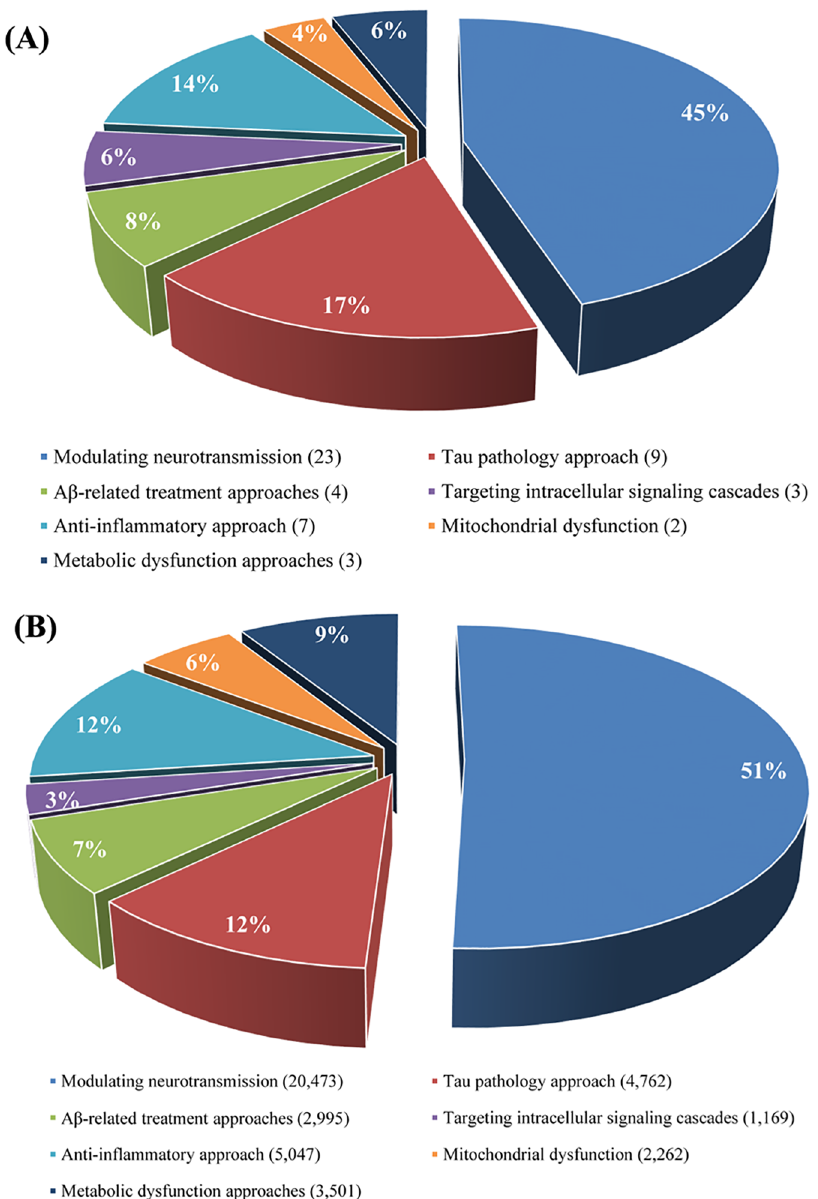
Fig 3. Targets (A) and active compounds(B) classification within the entire data set in AlzhCPI. minimum, lower quartile (Q1), median quartile (Q2), upper quartile (Q3), and maximum of MCC values of test sets. As shown in Fig 4A, among the four types of classifiers, the NB_ ECFP6 models (Q2 = 0.953) outperform the other three, and the NB_MACCS classifiers (Q2 = 0.651) perform the worst. However, there are no obvious differences between the perfor- mance of RP_ECFP6 (Q2 = 0.816) and RP_MACCS (Q2 = 0.757). As they are based on the same fingerprint, it is interesting that the NB_ECFP6 (Q2 = 0.953) models outperform RP_ ECFP6 (Q2 = 0.816), whereas the RP_MACCS (Q2 = 0.757) models outperform than NB_ MACCS (Q2 = 0.651). This indicates that the performance of the models derived from the dif- ferent algorithms depends on which fingerprint is used.